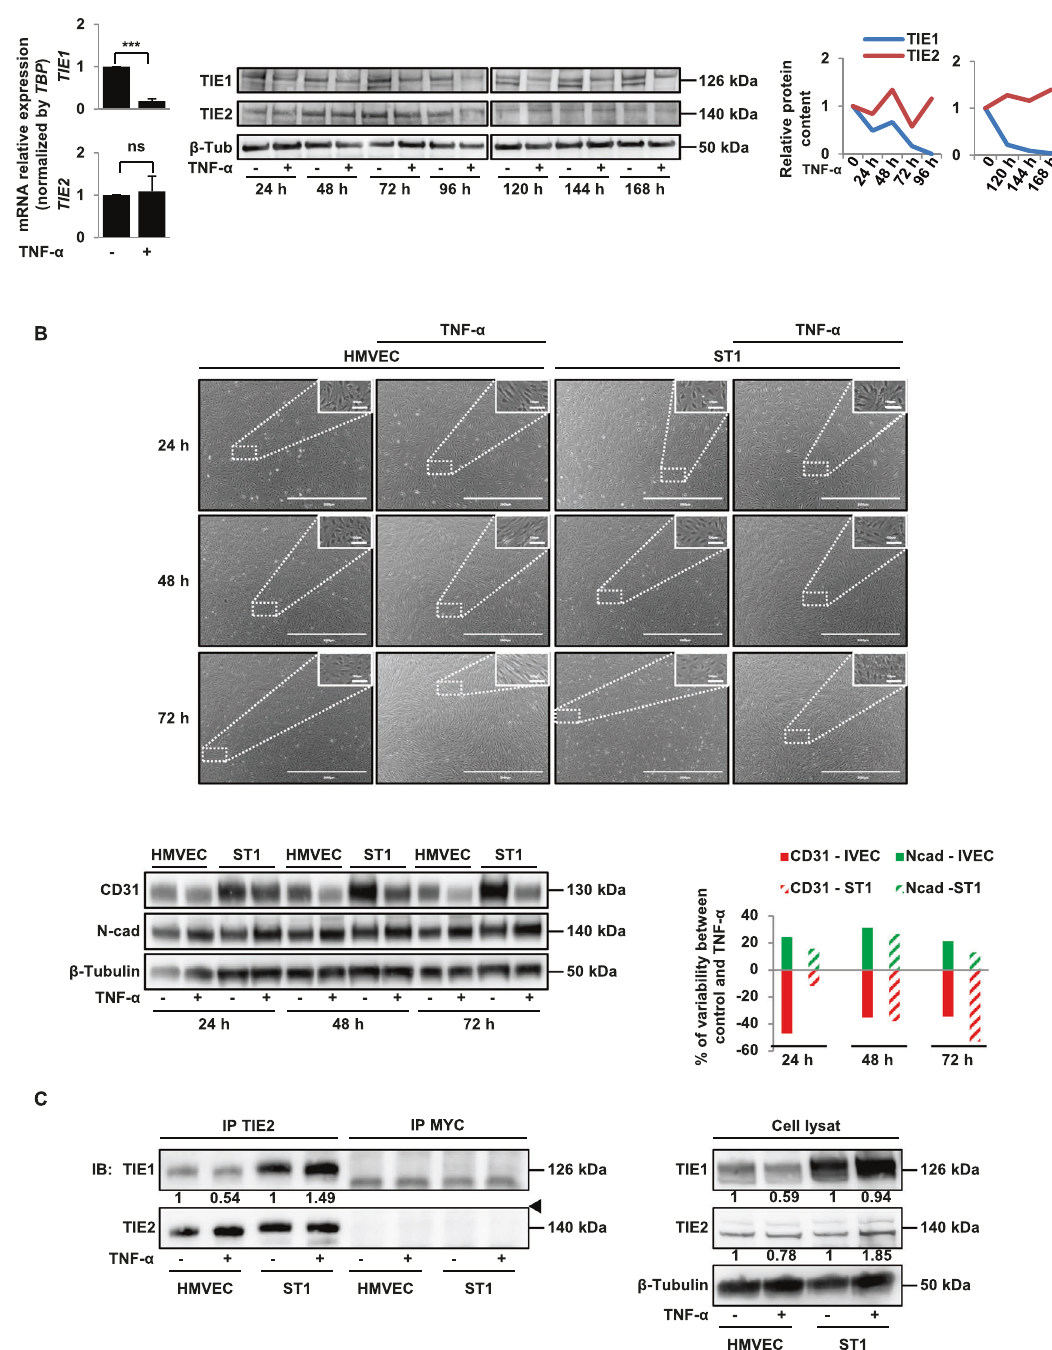
Fig. 4 Effects of TNF- α on TIE1 and TIE2 receptors. A TNF- α decreases the mRNA and protein expression of TIE1 and had no effect on TIE2 expression. HMVECs were treated various times with 100 ng/ml of TNF- α . mRNA and protein levels were quanti fi ed by RT-qPCR and western blot, respectively; graphs represent protein quanti fi cations. RT-qPCR histograms show the mean of three independent biological experiments, and western blots are representative of three independent biological experiments. B , C The overexpression of TIE1 induces a delay of TNF- α - induced EndMT ( B ) and increases TIE1/TIE2 interactions ( C ). Control HMVECs and TIE1 -encoding lentivirus infected clone (ST1) were treated various times with 100 ng/ml of TNF- α . Scale bars, 100 µm (inset) or 2000 µm. The graph represents the variation rate of proteins in presence of TNF- α . Lysates from control HMVECs and overexpressing TIE1 ST1 cells were subjected to immunoprecipitation with an anti-TIE2 or anti-MYC antibody, and TIE1 was detected by western blot. The arrow shows an aspeci fi c band. TBP for RT-qPCR and β -tubulin for western blot analysis were used as controls. Data are representative of three independent experiments. Signi fi cant differences are indicated by solid lines (*** P < 0.005 by t test). HMVEC human microvascular endothelial cell, EndMT endothelial – mesenchymal transition, TNF- α tumour necrosis factor- α , ST1 cells overexpressing TIE1, N-Cad N-cadherin, Ctrl control, mRNA messenger RNA, TBP TATA-box binding protein.